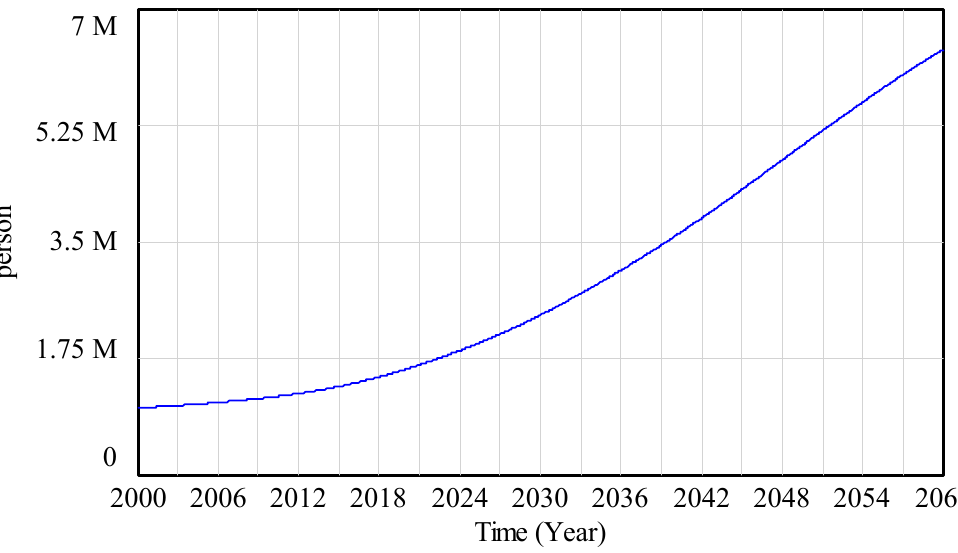
Figure A5. Population change over time.